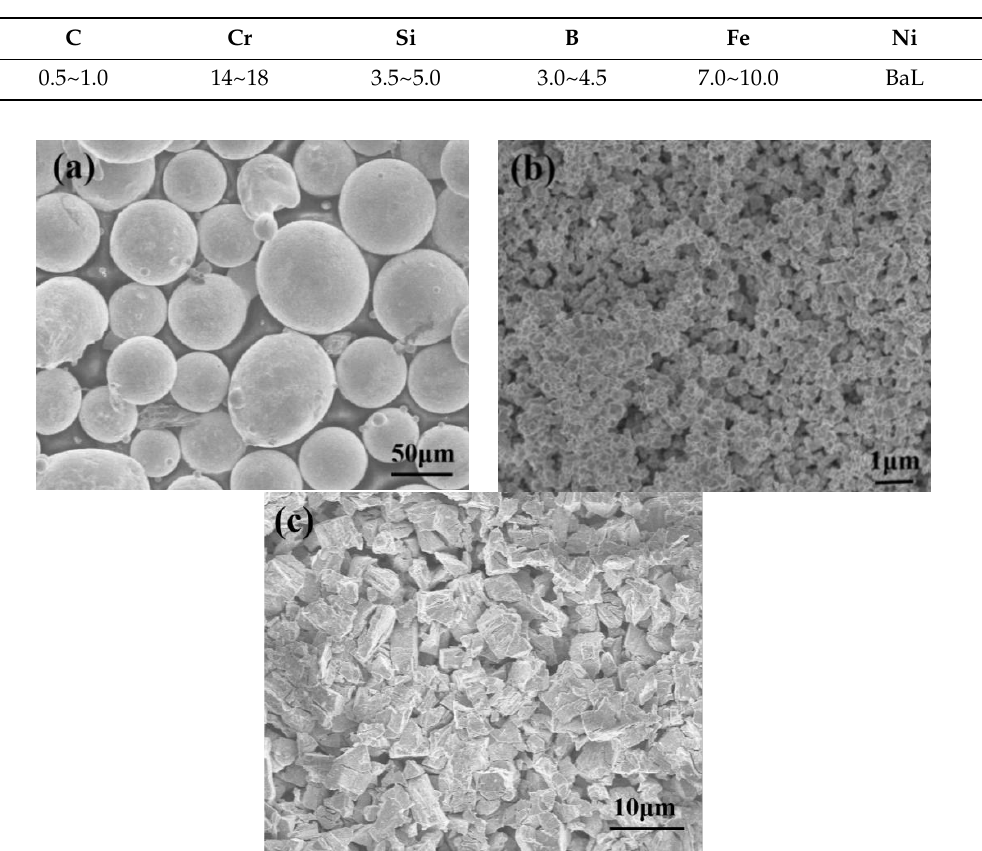
Figure 1. Morphology of the experimental powders: ( a ) Ni60, ( b ) nano-WC, and ( c ) CeO 2.